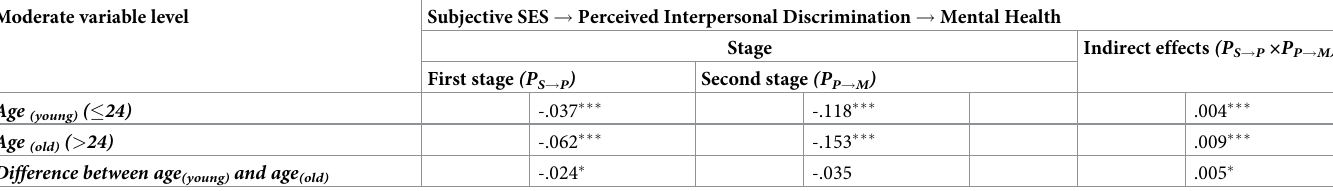
Table 5. Moderated mediation results across age